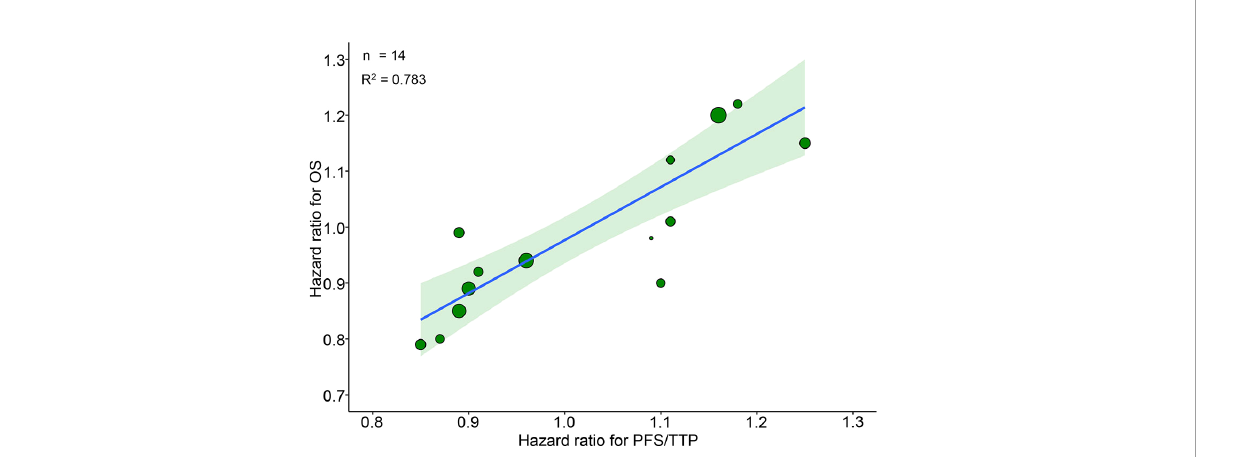
FIGURE 1 Trial-level correlation between hazard ratios for OS and PFS/TTP in phase III RCTs. Green circles represent trials with a size proportional to the number of patients, blue line for the estimated regression line and the light green zone for 95% con fi dence intervals. OS, overall survival; PFS/TTP, progression free survival/time to progression; RCTs, randomized controlled